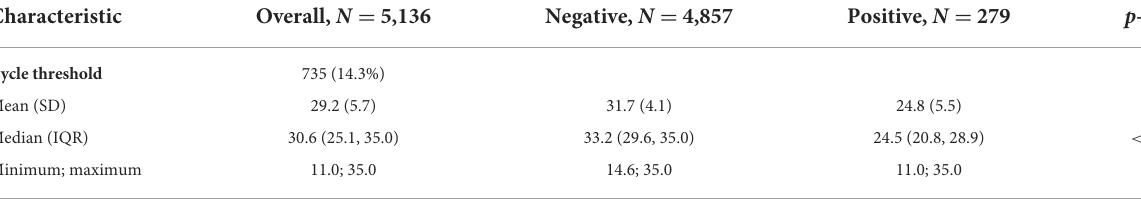
TABLE 6 Panbio RAD test results.